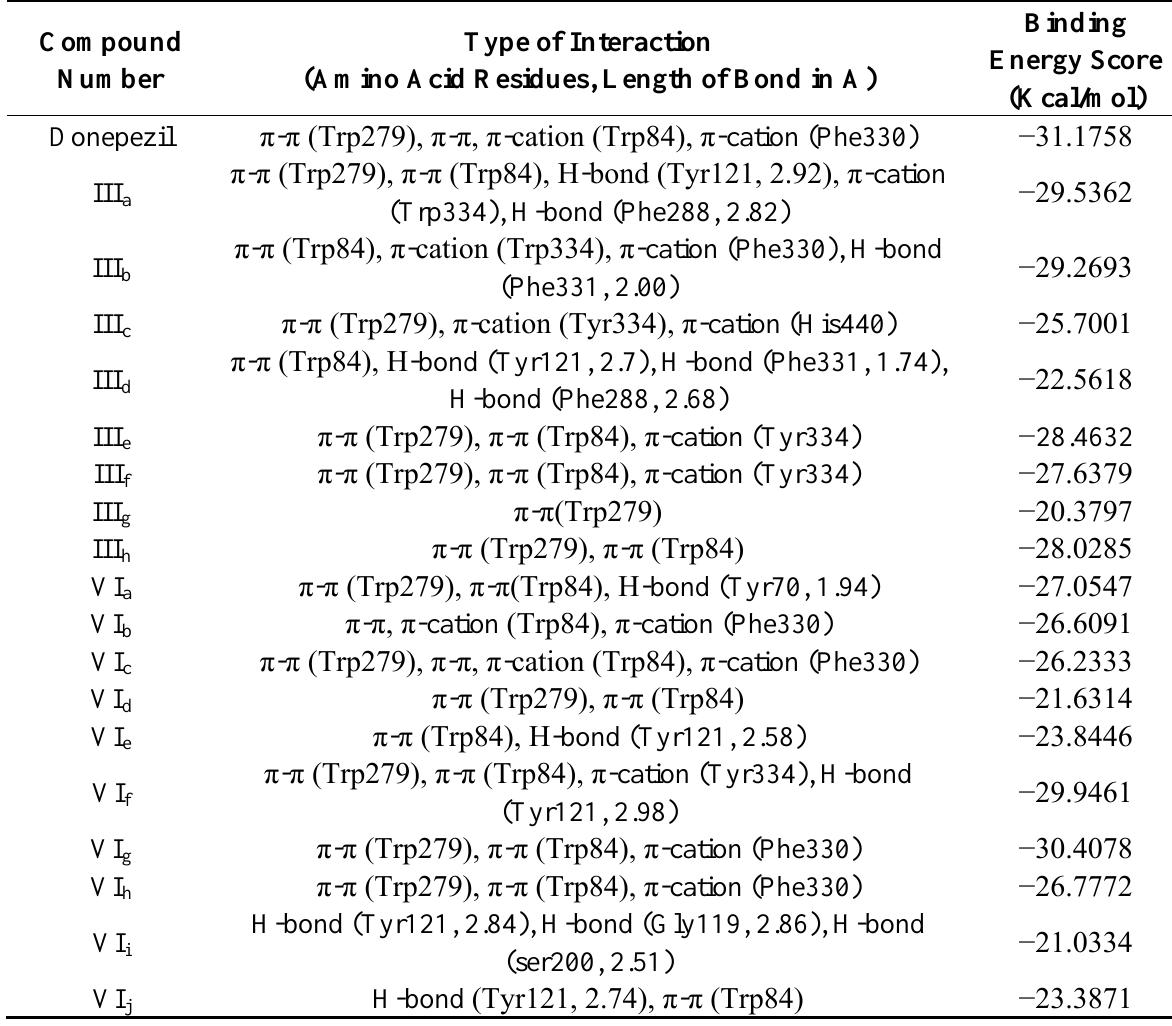
Table 2. MOE Scores of Donepezil, compounds III amino acid residues and their